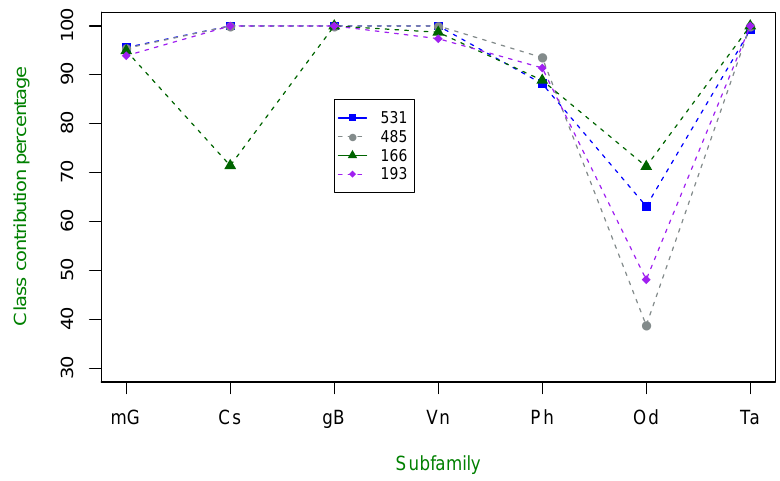
Figure 2. Class-specific percentage of contribution to overall classification using four amino acid property indices with the highest classification accuracy. metabotropic glutamate (mG), calcium sensing (Cs), GABA B (gB), vomeronasal (Vn), pheromone (Ph), odorant (Od) and taste